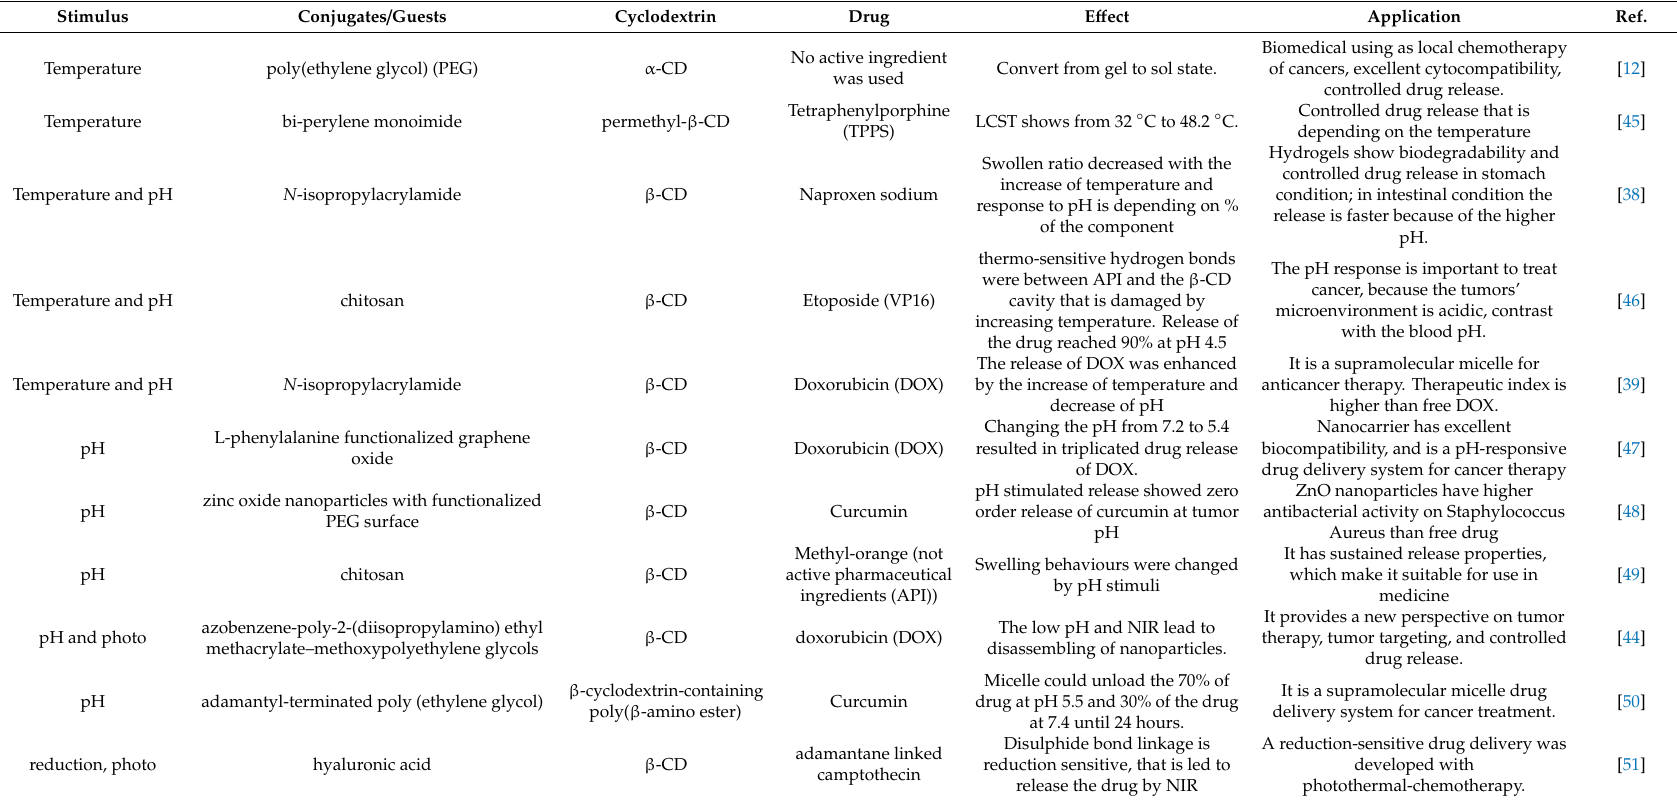
Table 1. Latest results on stimuli-responsive cyclodextrin drug delivery